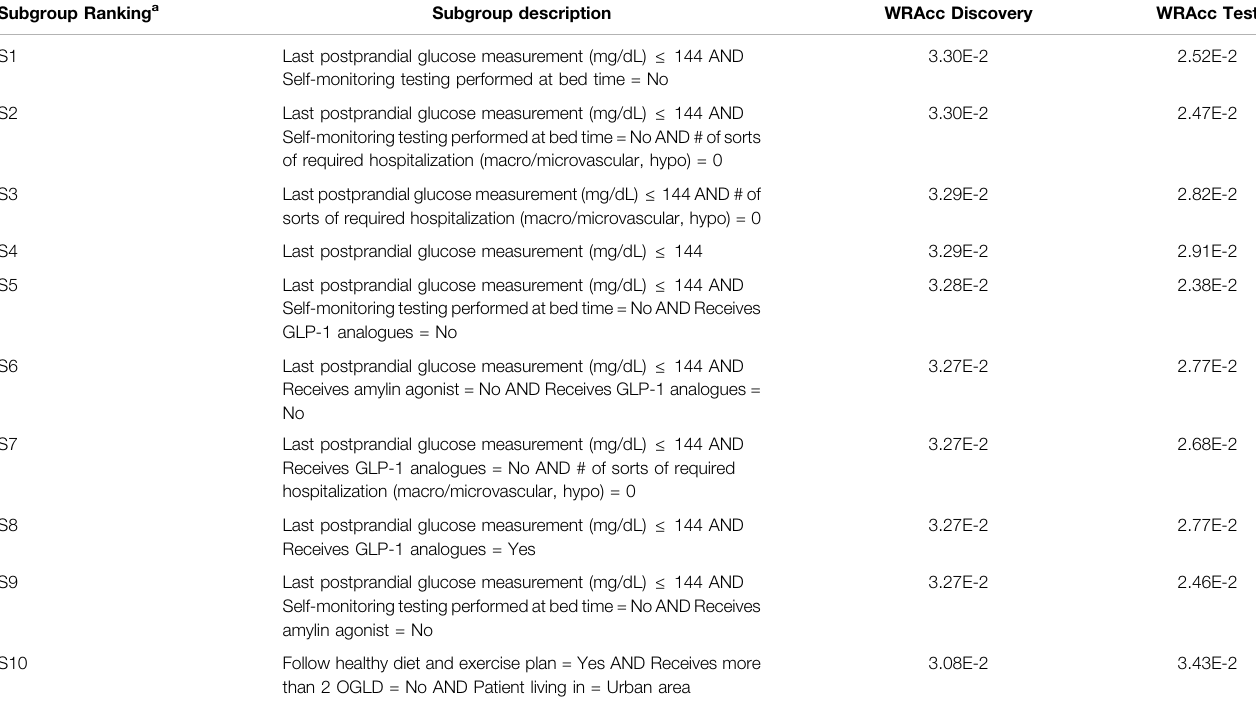
TABLE 2 | APRIORI-SD results on the detection of prognostic factors describing patients with better glycemic control. Subgroup Ranking